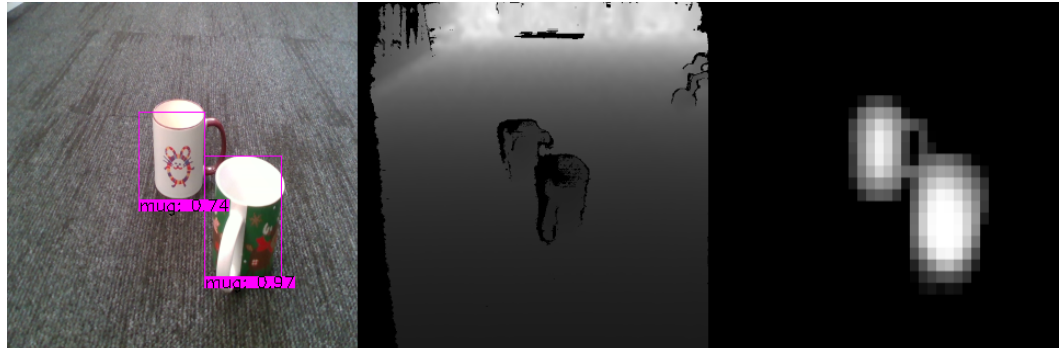
Figure 13. An example of real world object classification using the proposed network model: segmented and classified RGB frame ( left ), depth frame ( middle ), and predicted depth mask ( right ).